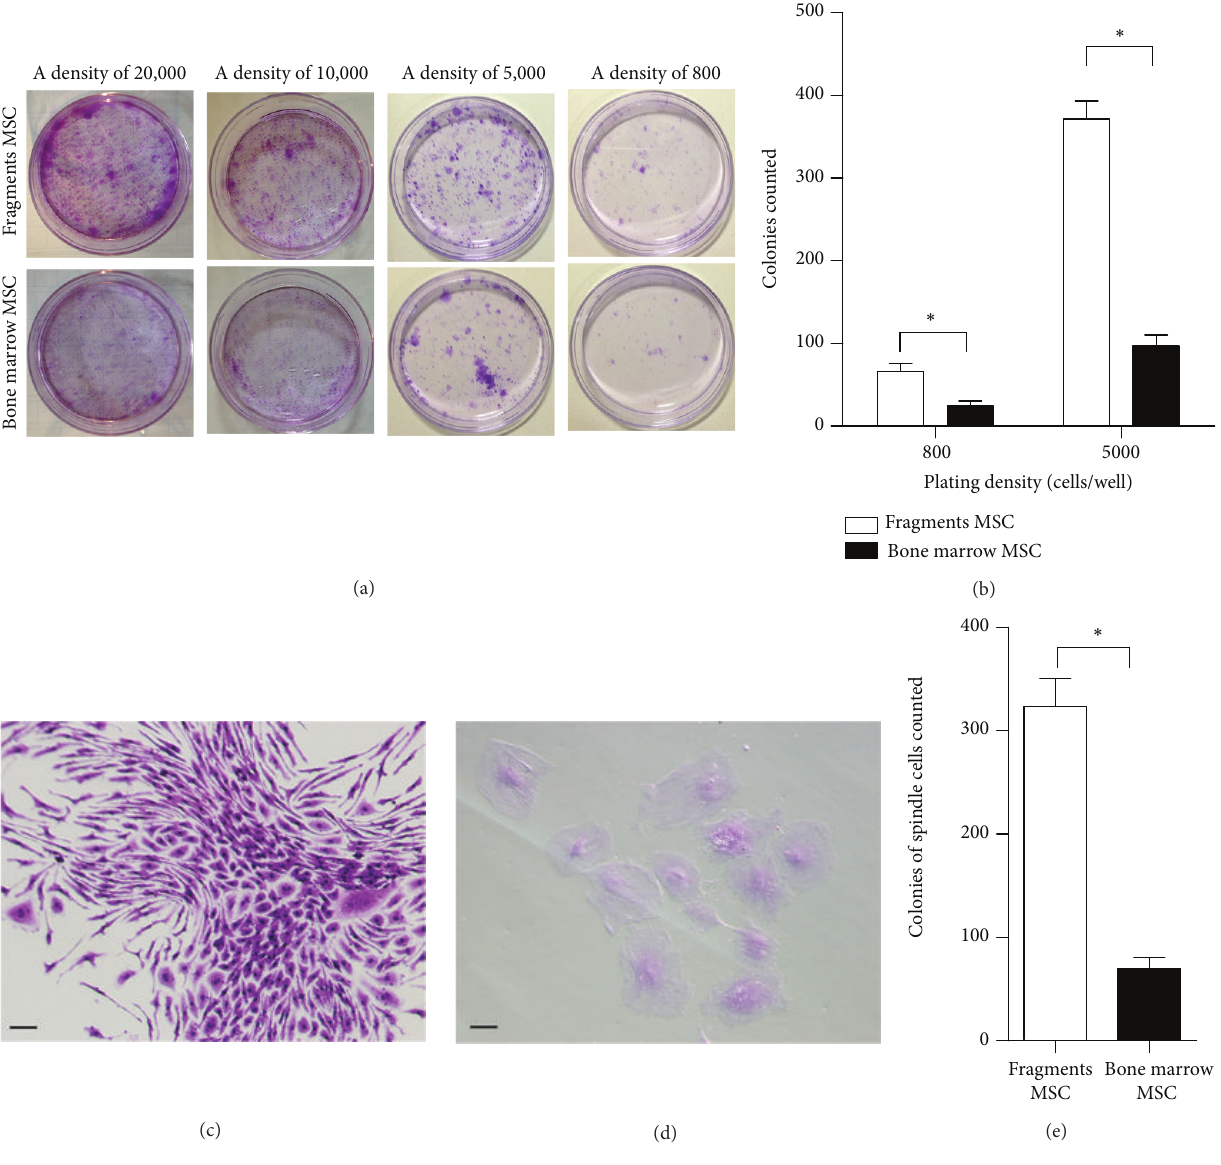
Figure 3: Analyses of cell CFU-F colonies of the first passage from cultured bone marrow and bone fragments. (a) Representative images of cell colonies at densities of 20,000, 10,000, 5,000, and 800 cells/well. (b) Colony counting analyses at densities of 5,000 and 800 cells/well. (c) Colony consisted of most of spindle cells. (d) Colony consisted of flattened cells. (e) Counting analyses for colonies which consisted of most of spindle cells at a density of 5,000 cells/well. Bar 20 𝜇 m; ∗ 𝑃 < 0.05